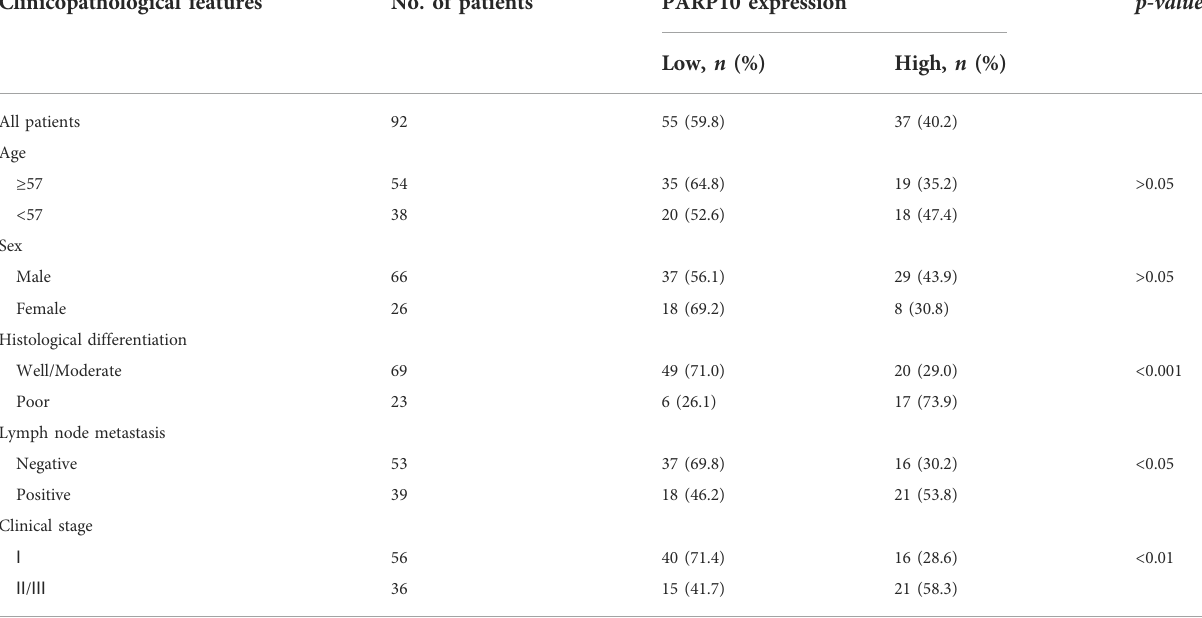
TABLE 1 The correlation between PARP10 expression and clinicopathological features in